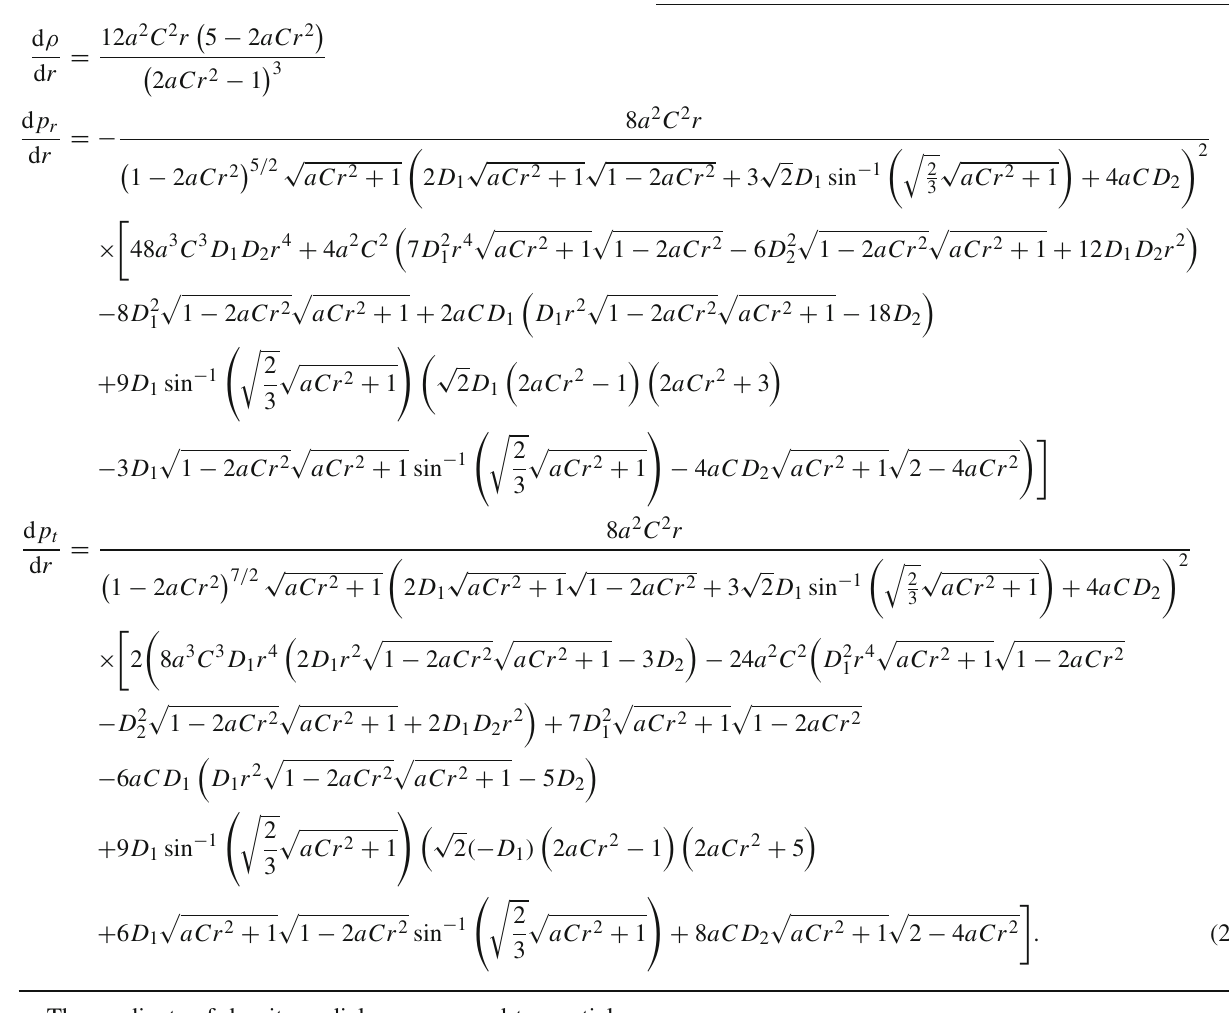
Fig. 5 Gradient of pressures and density ically in Fig. 5. For our model, gradients of density and radial pressure are shown to be negative throughout the structure. However, the gradient of transverse pressure is positive up to 7 . 45 km and then eventually becomes